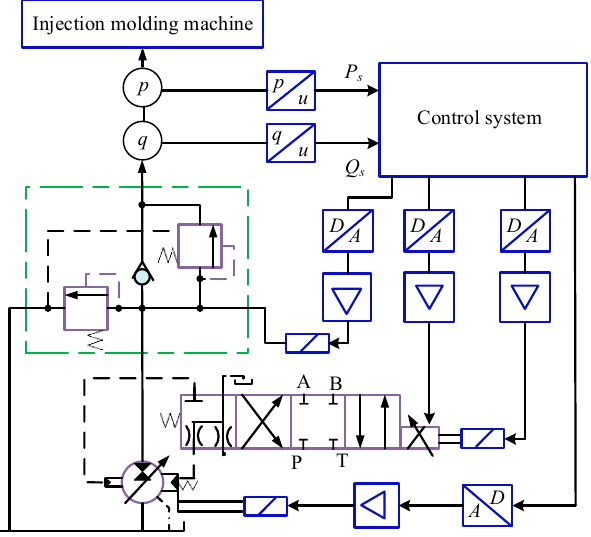
Figure 6. The electro-hydraulic system controlled P/Q compound proportional pump.